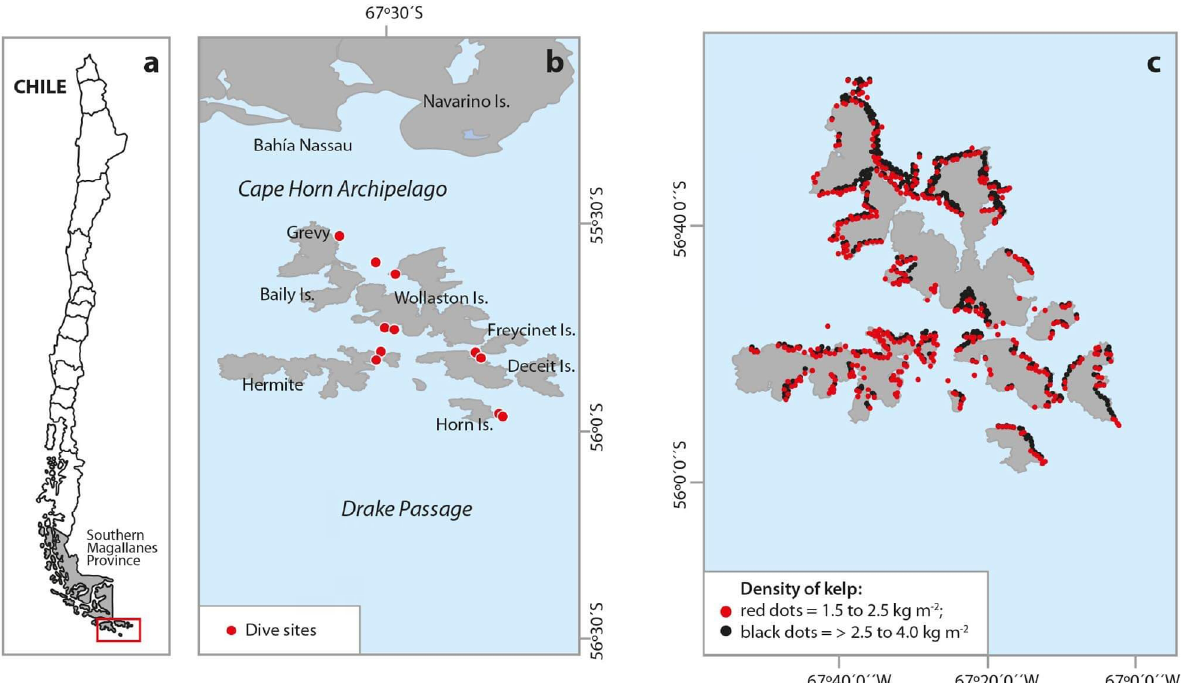
Figure 1. a) Location of Cape Horn Archipelago (CHA), southern Chile; b) sites at Wollaston Island where the photographic survey observed podding in the crustacean Paralomis granulosa around two species of sub Antarctic kelp forest (February 2017); red dots show diving sites; c) spatial distribution of abundance of the subtidal kelps Macrocystis pyrifera and Lessonia spp. around CHA (black dots are just high densities of red dots; 1.5 to 2.5 kg m -2 ; black dots just represent areas where the density of kelp was very high; > 2.5 kg m -2 ). Floating canopy of giant kelp was observed using the Landsat 8 Operational Land Imager (OLI) multispectral sensor. Kelp canopy biomass was ~ 2.5 ± 1.3 kg m -2 . Densities of M . pyrifera were nearly three times higher than densities of Lessonia spp. (Friedlander et al. ,